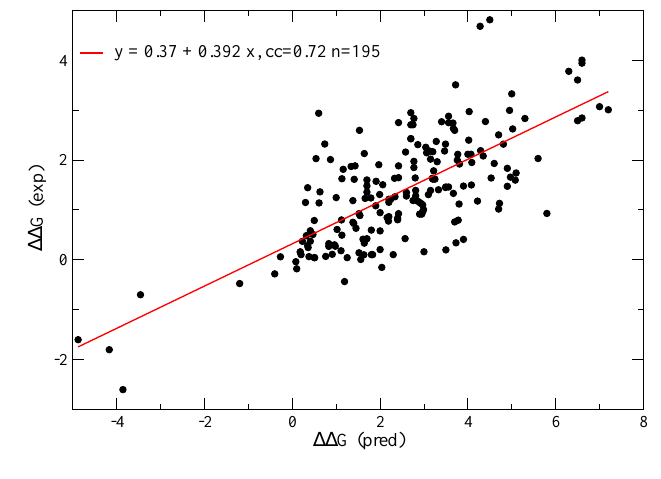
Figure 1. Computational predictions of the thermodynamic effect of mutations with the contact energy parameters of [26]. The 195 mutants were taken from